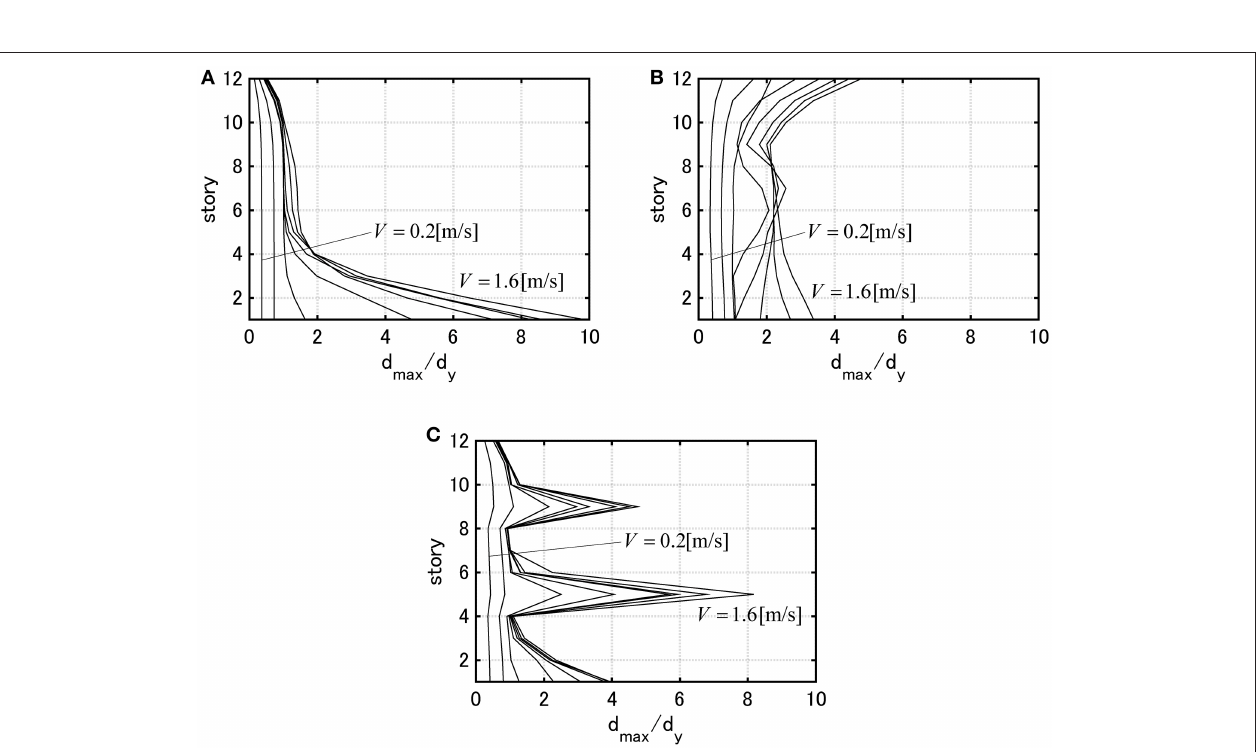
FIGURE 5 | Maximum interstory drift by DIP: (A) Model 1, (B) Model 2, (C) Model 3.